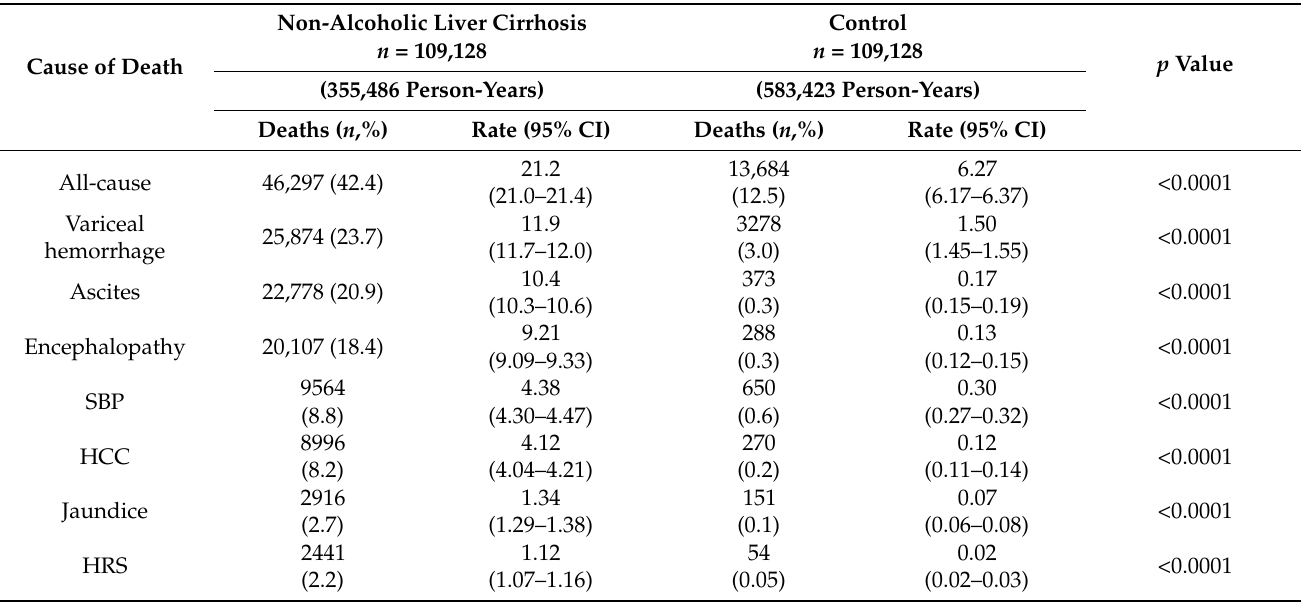
Table 2. Crude mortality rates per 100 person-years for the cirrhosis and control cohorts.